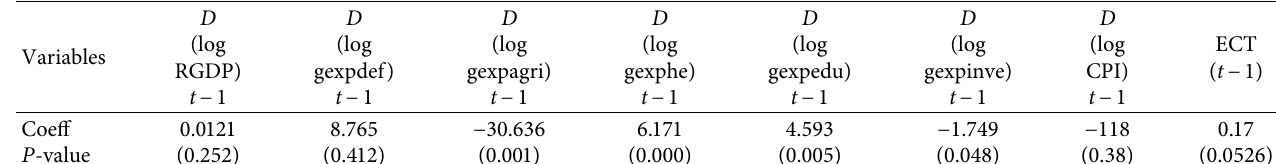
Table 7: Short run estimation of the VECM